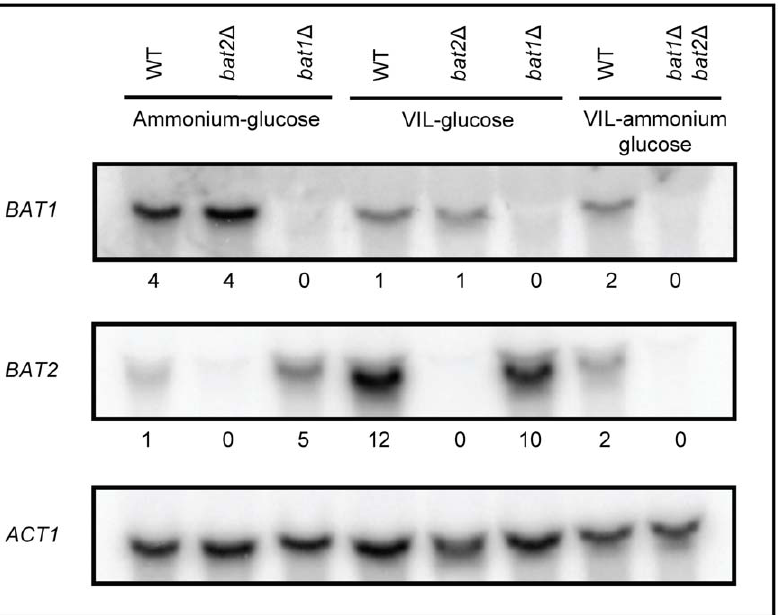
Figure 4. S.cerevisiaeBAT1 and BAT2 display divergent expression profile. Northern analysis was carried out on total RNA obtained from S. cerevisiae strains CLA1-2 (wild type), CLA31 ( bat1 D BAT2 ) and CLA32 ( BAT1 bat2 D ). Strains were grown on 2% glucose with either 40mM NH 4 SO 2 , VIL (150 mg/l, 100 mg/l or 30 mg/l of valine (V), leucine (L) or isoleucine (I) respectively or NH 4 SO 2 + VIL as nitrogen sources. Filters were sequentially probed with a 1500 bp BAT1 fragment, a 1450 bp BAT2 and a Bam H1- Hind III 1500 bp ACT1 DNA fragment as loading control. Numbers indicate relative expression as compared to: Lane 1 the WT grown on glucose VIL, Lane 2 WT grown on glucose NH 4 . Four biological replicates were performed, and representative results are shown.